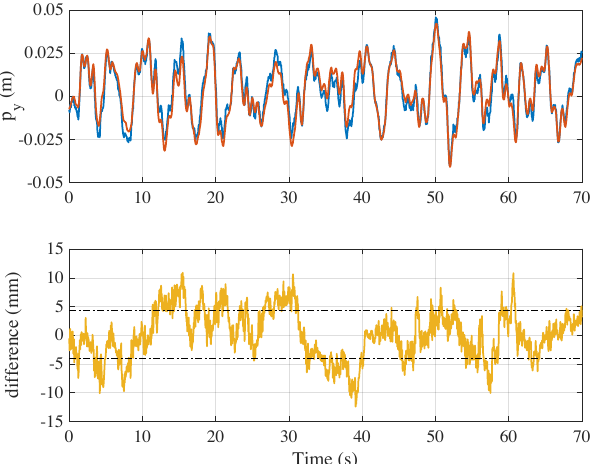
Figure 13. Comparison between the on-board and off-board estimations of the vision system data. In the upper panel, the estimation of the on-board altitude (blue solid line) is plotted together with the values (red solid line) measured by the fixed camera mounted on a tripod externally to the drone. Instead, the trend of the difference between the two estimates is reported in the lower panel. The mean deviation of such a difference is about 4.2 mm, while the maximum error value is around 1